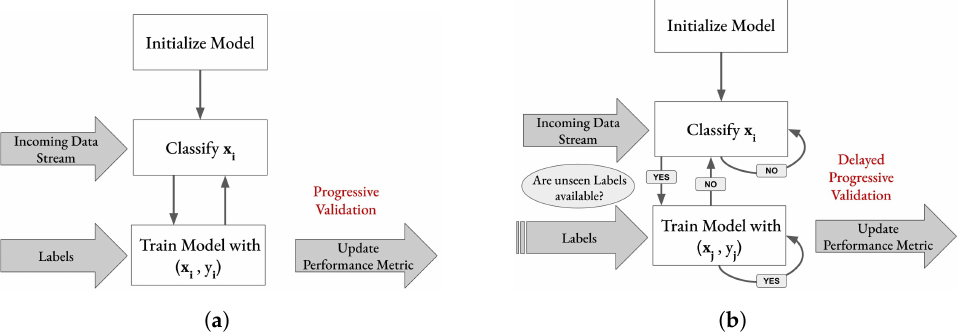
Figure 8. ( a ) Progressive validation incorporated into the basic flow of the training process (‘test- then-train’) of an online classifier in an immediate label setting. ( x i , y i ) represents an input feature vector and its corresponding label. ( b ) Evaluation incorporated into the basic flow of the training process of an online classifier when labels arrive delayed ( i ≥ j